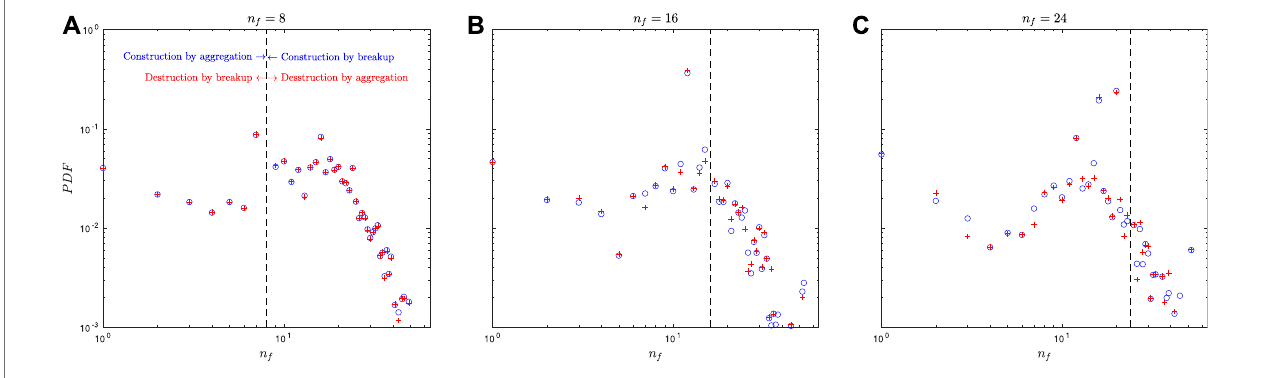
FIGURE 8 | Case P 2 S 2 with smaller stickiness and larger stiffness. (A) Probability density function (PDF) that a fl oc of size n f becomes a fl oc of size n f = 8 in a non- dimensional time period of2(bluecircles) and thePDF thata fl ocofsize n f =8 evolvesinto a fl ocofsize n f over the same period (redpluses). (B,C) Same asframe-(A) for n f = 16 and